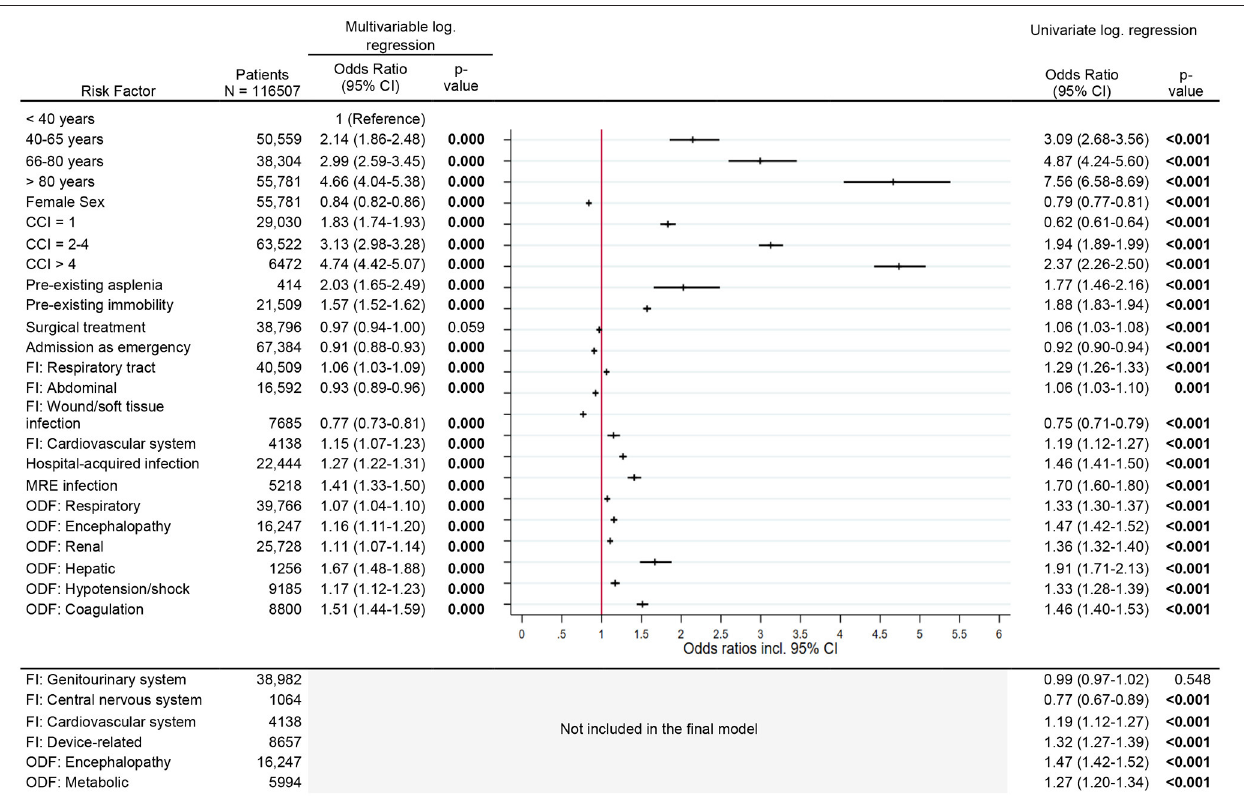
FIGURE 5 | Risk factors for 12-months mortality. Legend: CCI, Charlson Comorbidity Index; FI, Focus of infection; MR, Multi-resistant; ODF, Organ